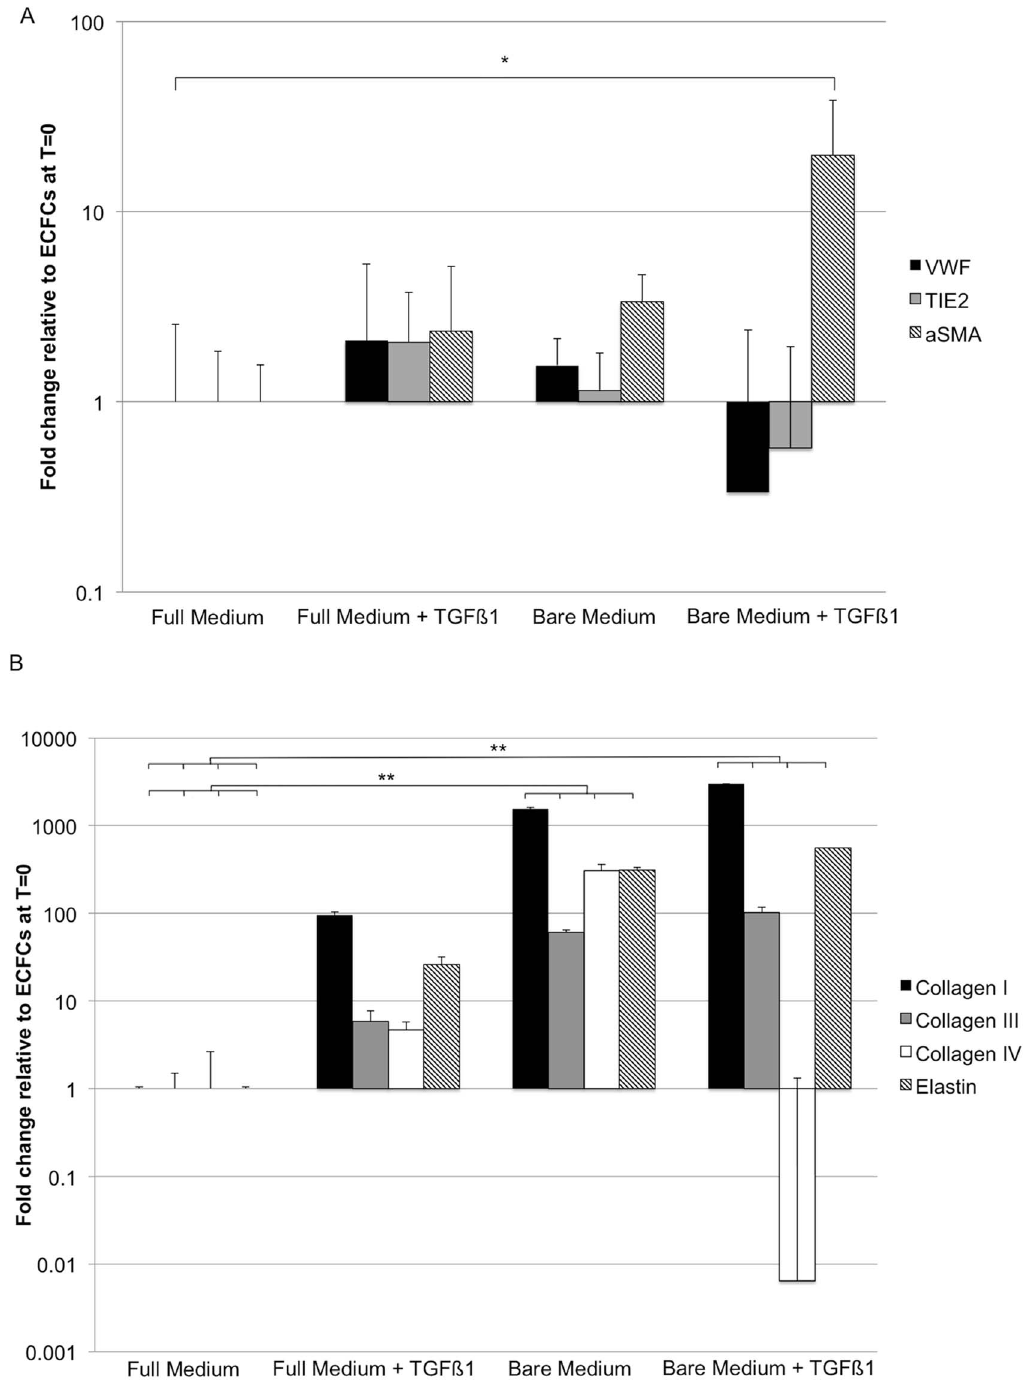
Figure 5. qPCR of ECFCs cultured in 2D for 14 days on collagen type I coating. (A) Full medium + TGF b 1 and bare medium showed an increased a SMA expression compared to ECFCs of full medium. Bare medium + TGF b 1 showed a light downregulation of endothelial markers VWF and TIE2, while the expression of a SMA was significantly upregulated. (B) With full medium + TGF b 1 and bare medium with or withour TGF b 1 a significant increase in collagen type I, III and elastin was detected. A decrease in collagen IV expession was found for collagen type IV. *=p , 0.05, **=p , 0.01, N=3.